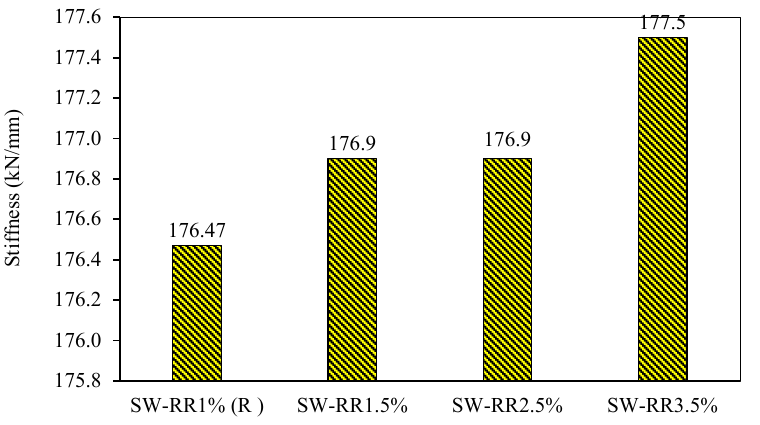
Figure 10. Stiffness of Group 1.